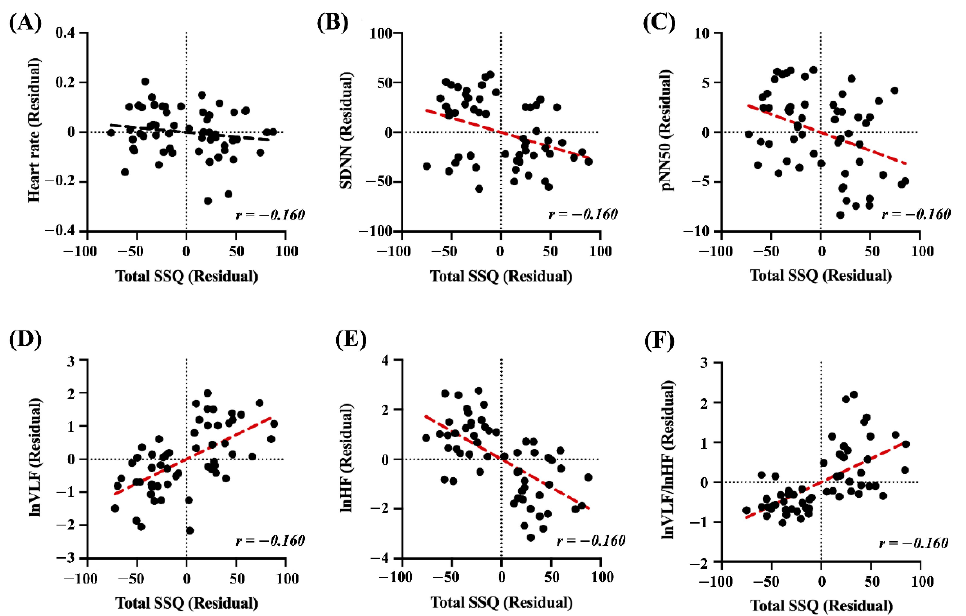
Figure 6. Results of the partial correlation analysis between the total SSQ score and cardiac features (red dotted line, p < 0.001). ( A ) Heart rate. ( B ) SDNN. ( C ) pNN50. ( D ) ln VLF. ( E ) ln HF. ( F ) ln VLF/ ln HF ratio.